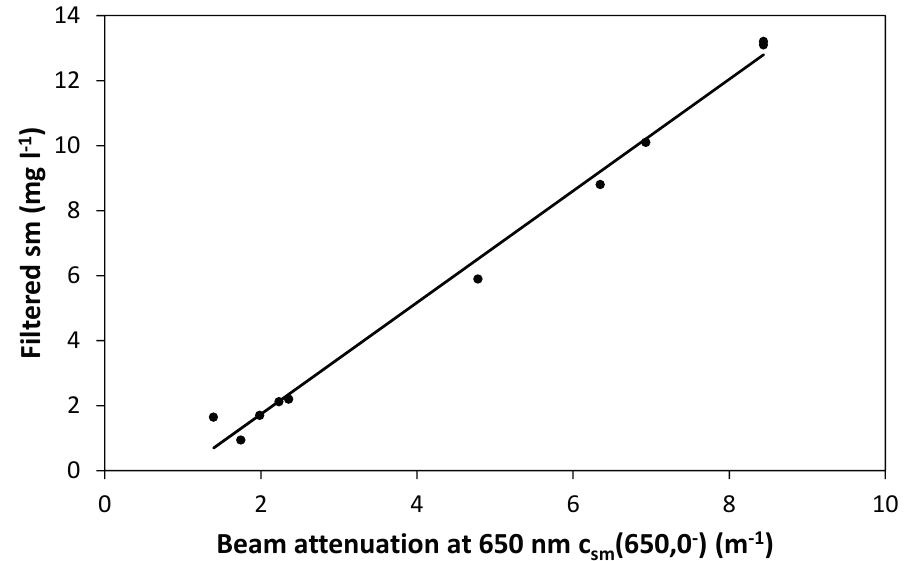
(650,0 − ) − 1.696, with the sm